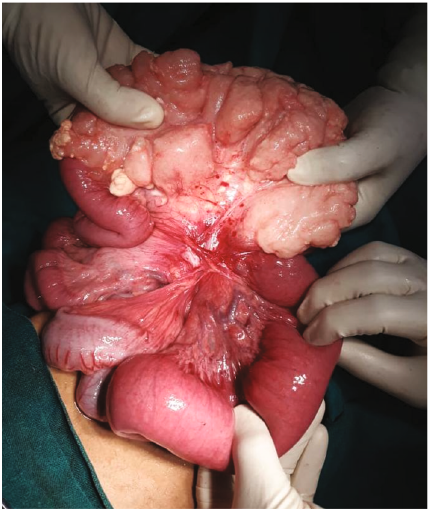
Figure 1: Intraoperative image showing a huge lobulated, multicystic mesenteric mass attached to the small